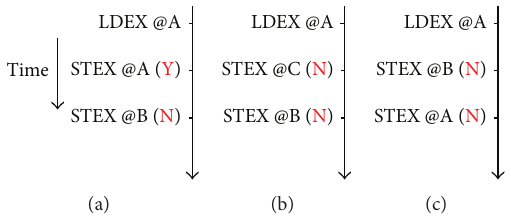
Figure 12: An example of exclusive transactions. (a) The correct implementation. (b) The wrong execution result caused by a design error. (c) The wrong simulation result caused by the timing incon-